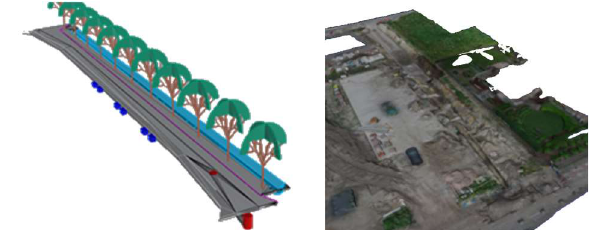
Figure 2: The IFC-file from the test-site (left) the mesh from the test-site (right) (Mariakerke)